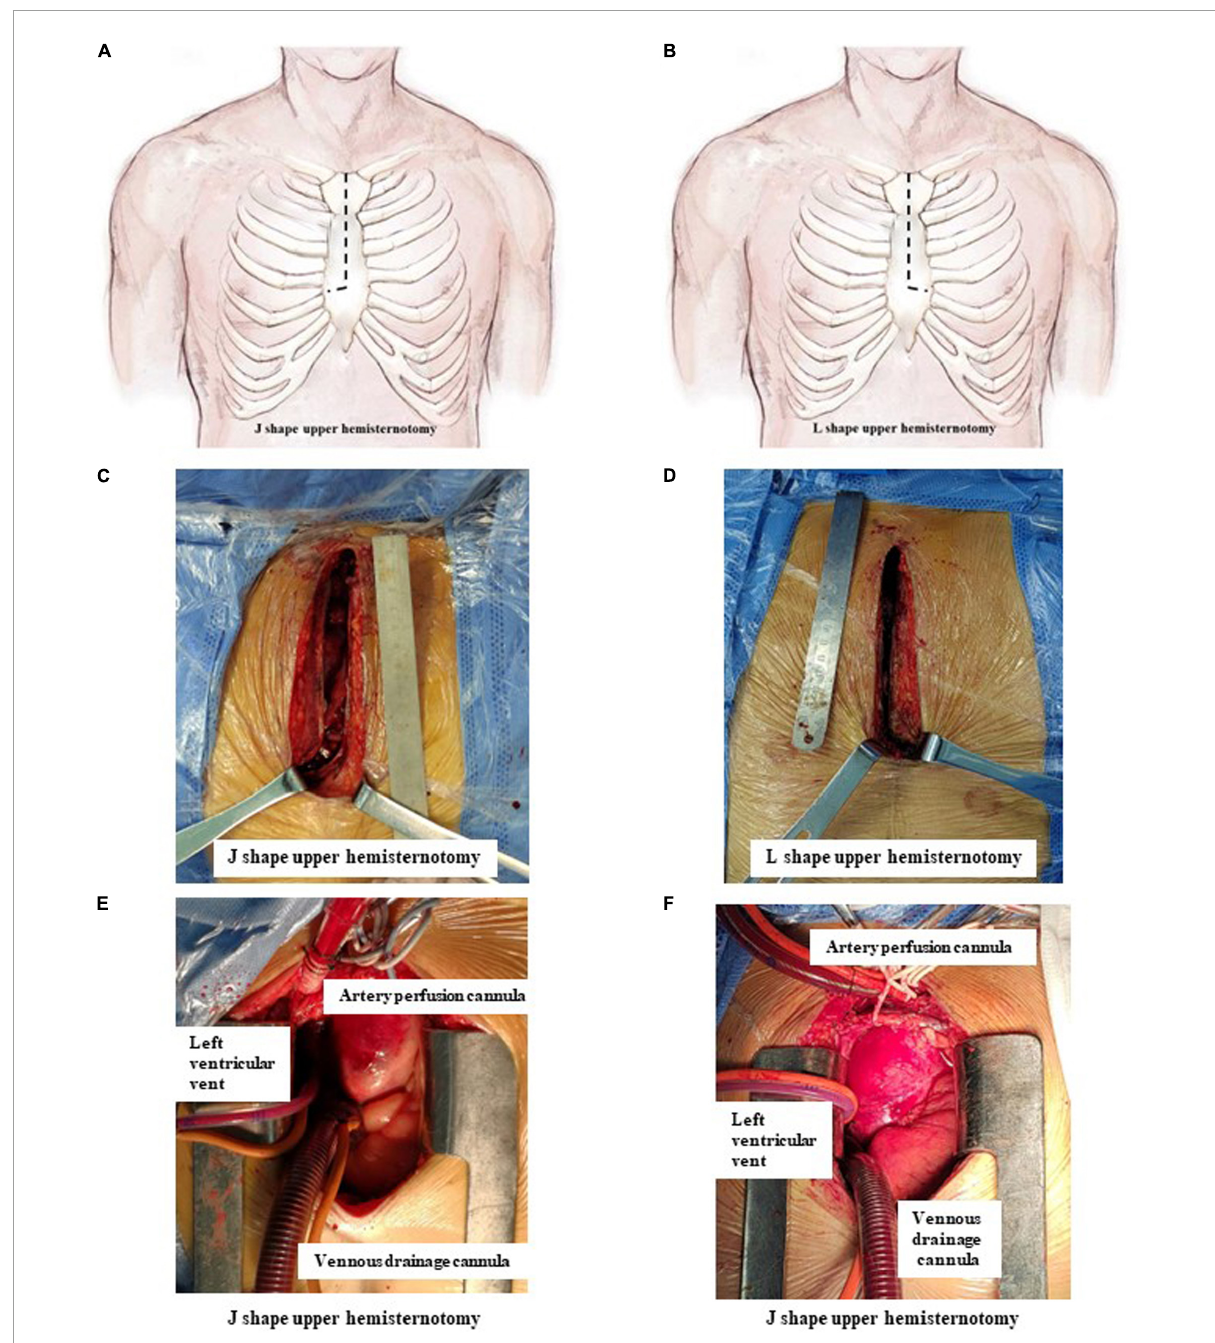
FIGURE1 J- and L-shaped upper hemisternotomy. (A,C) J-shaped upper hemisternotomy is opened from the sternal notch to the fourth intercostal space and then extended to the right fourth intercostal space. (B,D) L-shaped upper hemisternotomy is opened from the sternal notch to the fourth intercostal space and then extended to the left fourth intercostal space. (E) Cannulation finished via J-shaped upper hemisternotomy. (F) Cannulation finished via L shape upper